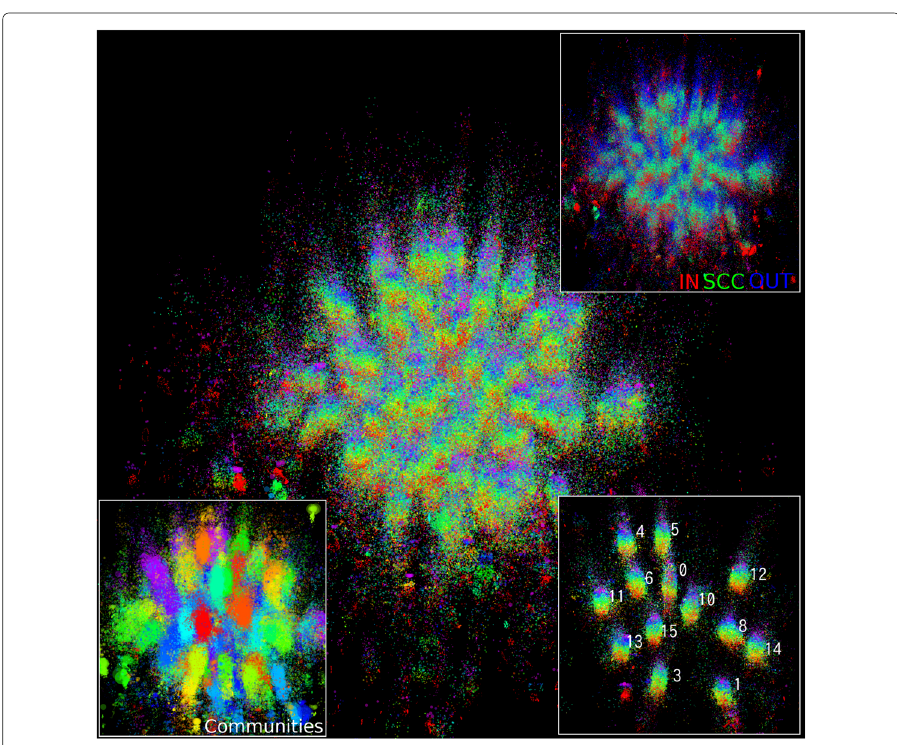
Fig. 5 Bow-tie locality of the Google web data. Main plate colored to incoming degree share in the whole degree, from high to low in purple, blue, green, yellow and red. Upper right inset shows In, SCC and OUT segments in blue, green and red. Lower left inset shows community detection result. Many small bow-ties are found in the picture and most of those small bow-ties form different communities. Several visually disjoint segments are selectively shown in the lower right inset for easy recognition of bow-tie